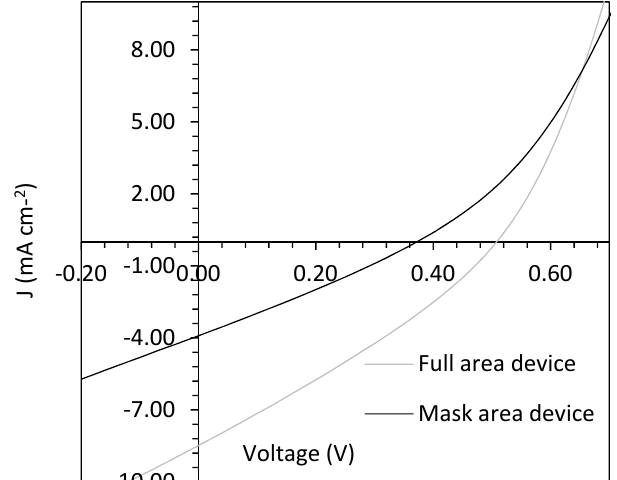
Table 2. J-V analysis of OPV based on graphene electrode at different areas.